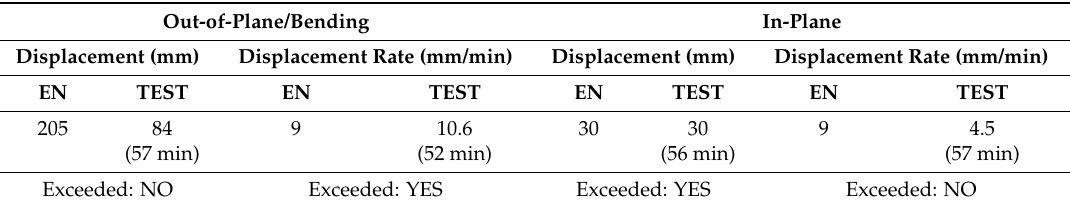
Table 3. Reference performance parameters for the W80 specimen, in accordance with EN 1363-1 provisions (in brackets, the time of maximum measurements from the test